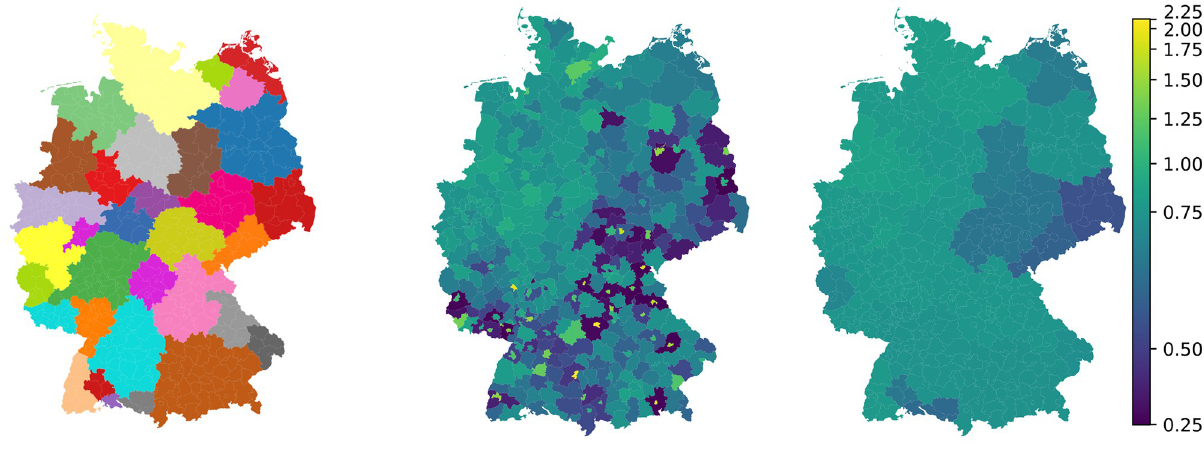
Fig 2. Intermediate-sized labor market regions (left; cf. [43]). Reported (center) and approximated (right) vaccination ratios for age group 18–59 as of November 02, 2021. Ratios computed by dividing vaccinations up to November 02, 2021 by local population size. Using geodata “Verwaltungsgebiete 1:2 500 000, Stand 01.01. (VG2500)” from https://gdz.bkg.bund.de, copyright; GeoBasis-DE / BKG 2021, license dl-de/by-2–0, see https://www.govdata. de/dl-de/by-2-0.